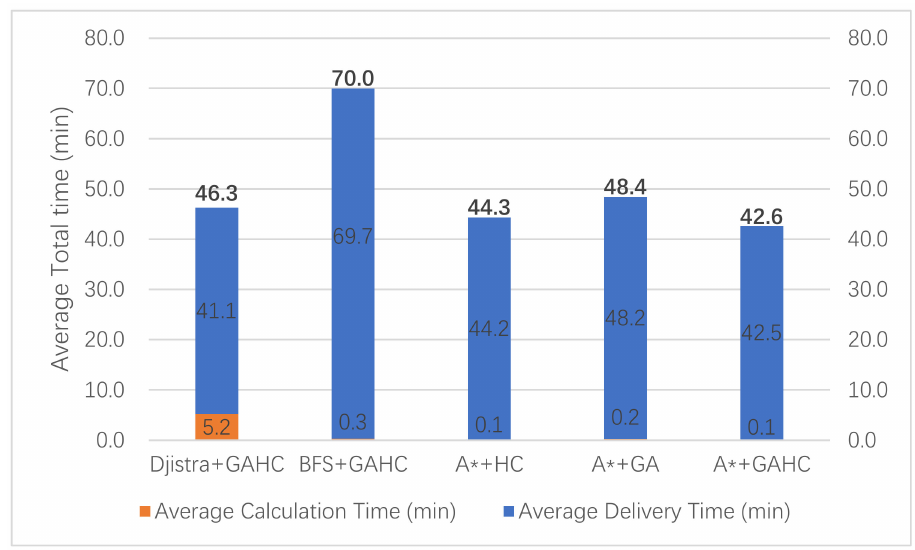
Figure 17. Average total time in various